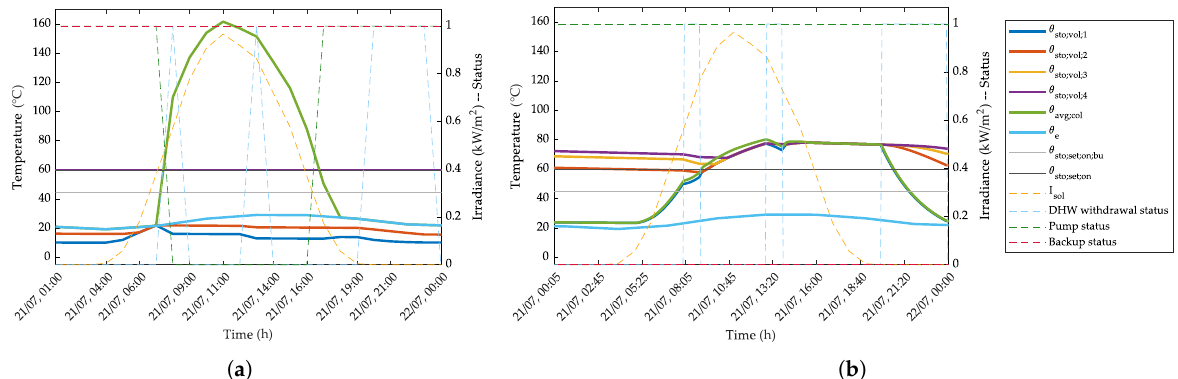
Figure 14. The effect of the time step on simulations featuring lower reference differential threshold (0 K): ( a ) t ci = 1 h, and ( b ) t ci = 5 min.